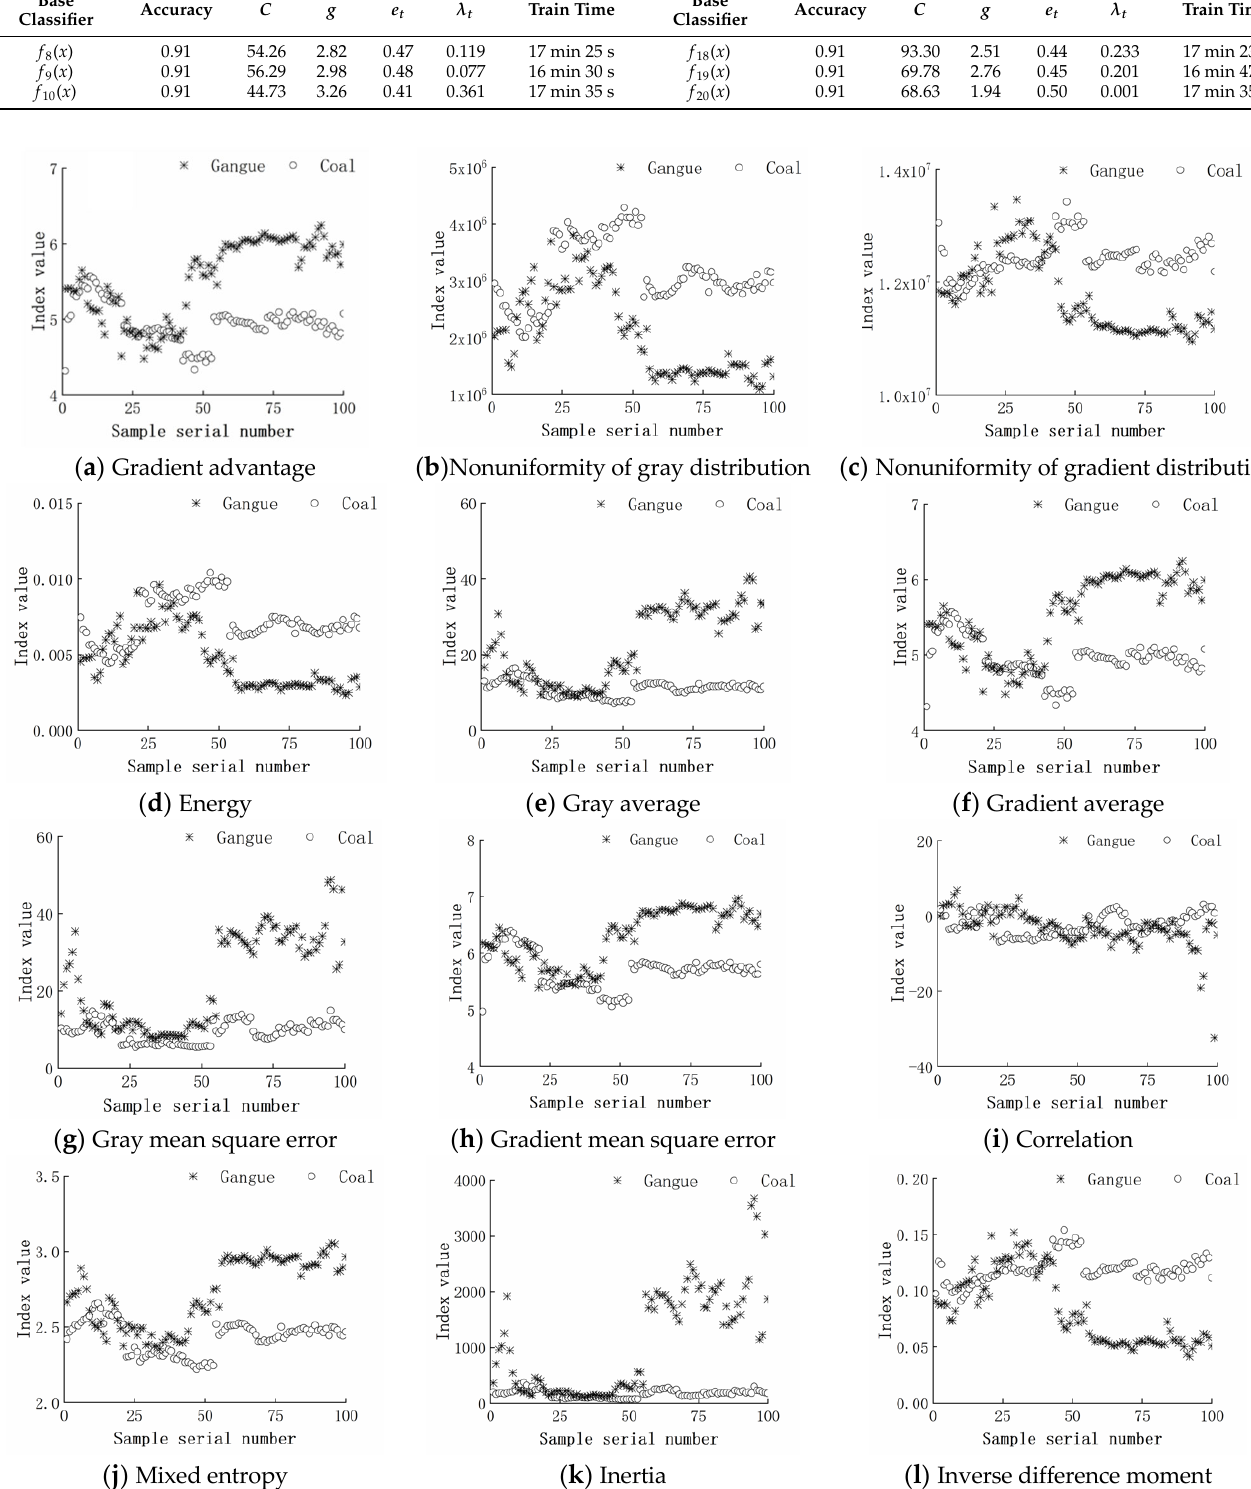
Figure A1. Texture features of sample of coal-gangue image.